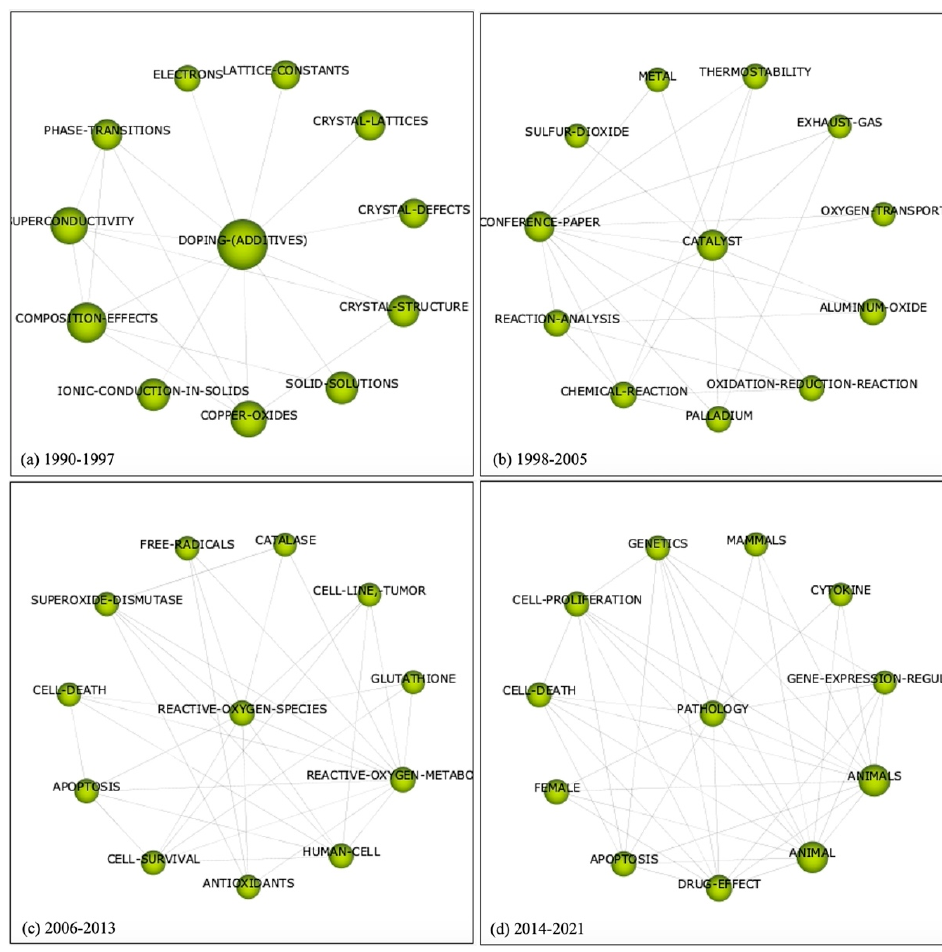
Figure 3. Main themes in the cerium oxide related publications from the Scopus database, over four time periods identified using SciMAT software ( a ) 1990–1997 ( n = 1047); ( b ) 1998–2005 ( n =